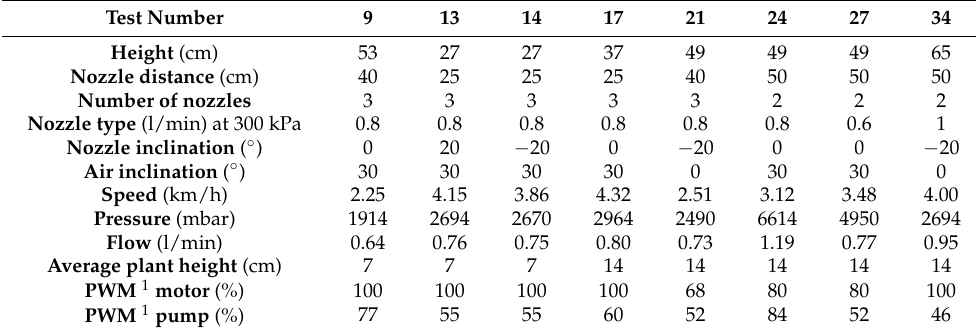
Table 2. Parameters from the tests 9, 13, 14, 17, 21, 24, 27 and